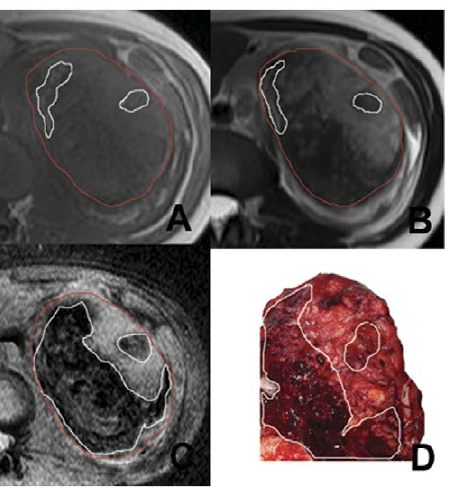
Figure 2. Left renal ccRCC with a grade III tumor in the Fuhrman system. Two patchy hemorrhage lesions with hyperinten- sity (area demarcated by the white boundary) are seen on T1WI (A) while one hypo- and one hyper-intensity hemorrhage lesions (area demarcated by the white boundary) are seen on T2WI (B) within the tumor region (area demarcated by the red boundary). On SWI (C), extensive hemorrhage lesions with hypointensity (areas demarcated by the white boundary) are present within the tumor region. In gross pathology (D), extensive hemorrhage lesions (areas demarcated by the white boundary) are seen in the tumor.